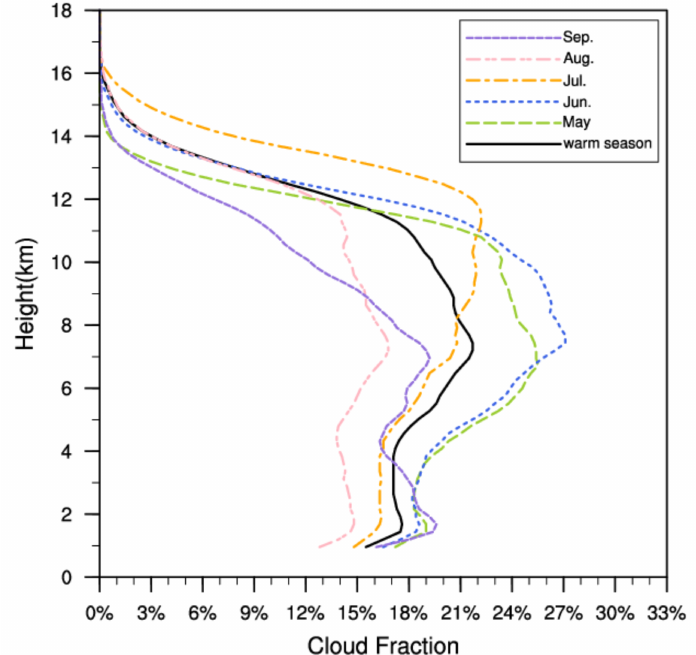
Figure 3. Vertical distribution of the cloud fraction for May (green), June (blue), July (orange), August (pink), September (purple), and the whole warm season (black) during